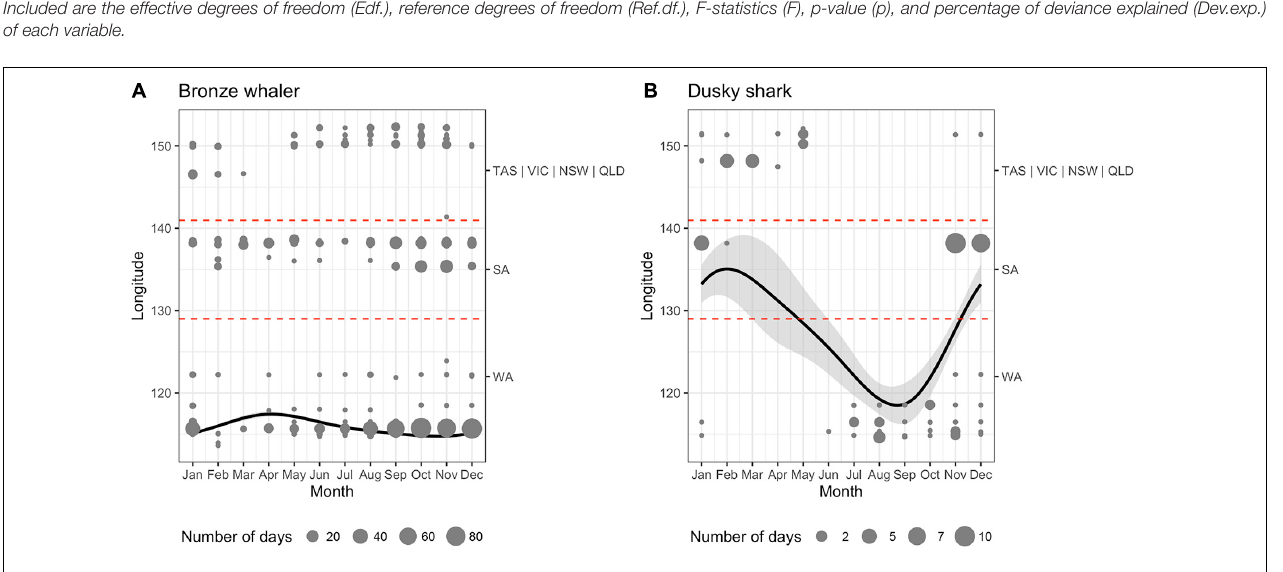
FIGURE 4 | Generalized Additive Mixed Models (GAMM) of longitude variation as a function of month for all tagged (A) bronze whaler and (B) dusky sharks. Shaded areas, points, and dashed lines, respectively, represent the 95% confidence intervals, the raw location data weighted by the number of days detected in each station (point size), and the longitudinal boundaries between states (WA, Western Australia; SA, South Australia; VIC, Victoria; and NSW, New South